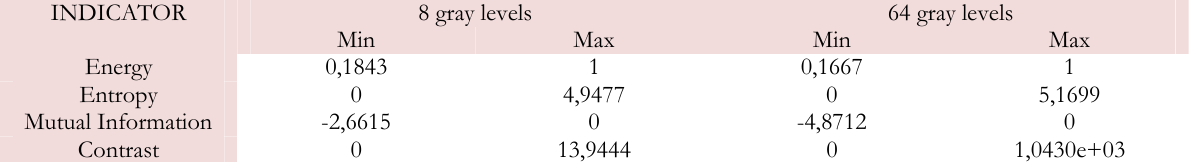
Figure 35: Mutual information 64 gray levels.